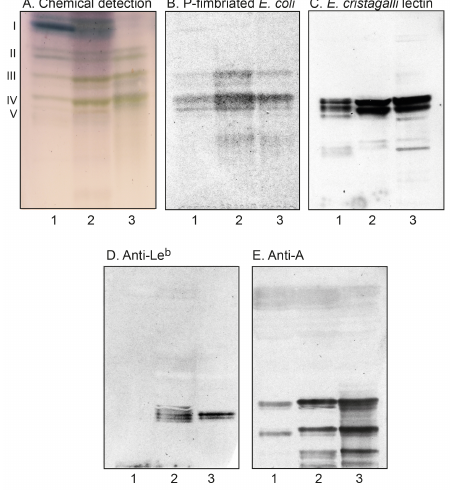
Figure 1. Thin-layer chromatography of the non-acid glycosphingolipids of human parathyroid and thyroid glands, and binding of carbohydrate-recognizing ligands. Thin-layer chromatogram after detection with anisaldehyde ( A ), autoradiograms obtained by binding of Gal α 4Gal-recognizing P-fimbriated E. coli ( B ), Gal β 4GlcNAc-/Fuc α 2Gal β 4GlcNAc-binding lectin from E. cristagalli ( C ), monoclonal antibodies directed against the blood group Le b determinant ( D ), and the blood group A determinant ( E ). The lanes were: lane 1, total non-acid glycosphingolipids of human parathyroid glands, 80 µ g; lane 2, total non-acid glycosphingolipids of human thyroid glands, 80 µ g; lane 3, reference total non-acid glycosphingolipids of human blood group AB erythrocytes, 40 µ g.The roman numbers to the left of ( A ) denote the approximate number of carbohydrate units in the